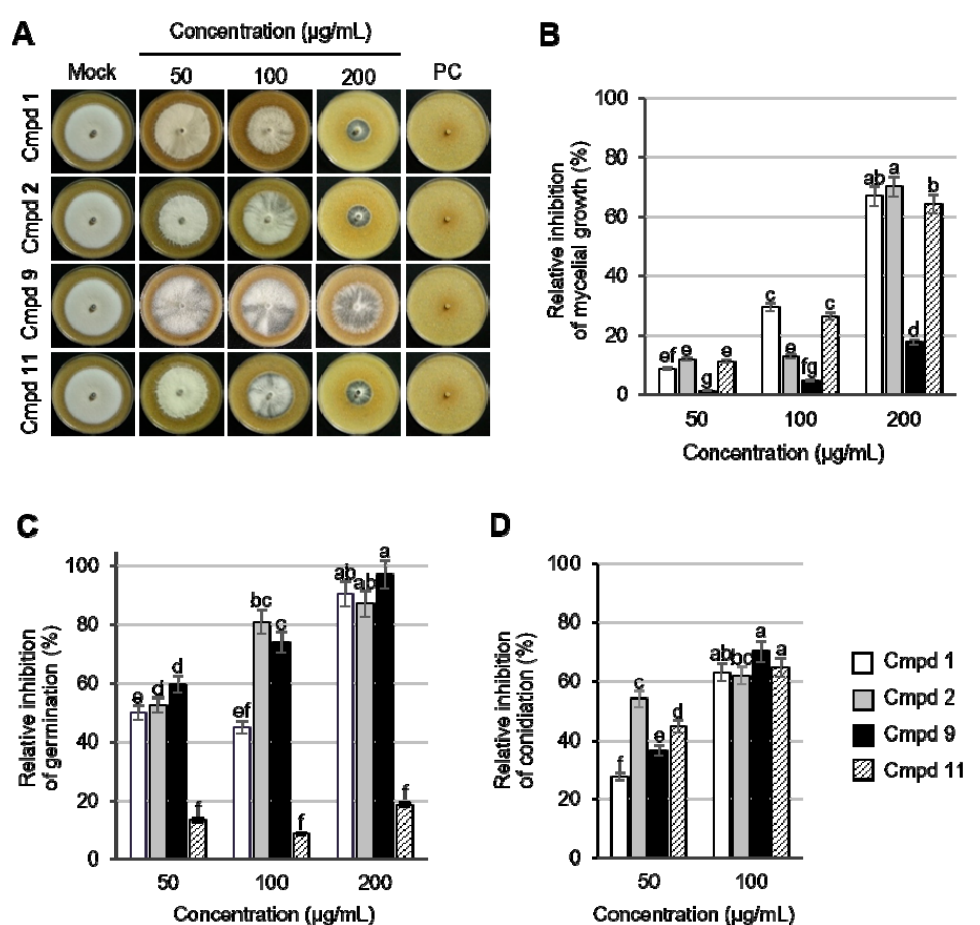
Figure 2. Effects of compounds 1 , 2 , 9 , and 11 on the development of Magnaporthe oryzae . ( A ) Mycelial growth of M. oryzae grown on RPA medium at 7 dpi. PC, cycloheximide (5 µ g/mL) ( B ) Relative inhibition of mycelial growth at 7 dpi. ( C ) Relative inhibition of germination at 6 hpi. ( D ) Relative inhibition of conidiation at 10 dpi. Relative inhibition (%) for all experiments was calculated by comparison to the non-treatment control. The bars represent the mean ± standard deviation of two runs with three replicates. The bars with different letters are significantly different from each other at p < 0.01 according to Duncan’s new multiple range test. Cmpd 1 , pinusolide (white bar); cmpd 2 , 15-methoxypinusolidic acid (grey bar); cmpd 9 , 8 β ,18-dihydroxysandaracopimar-15-ene (black bar); cmpd 11 , α -cedrol (lined bar).